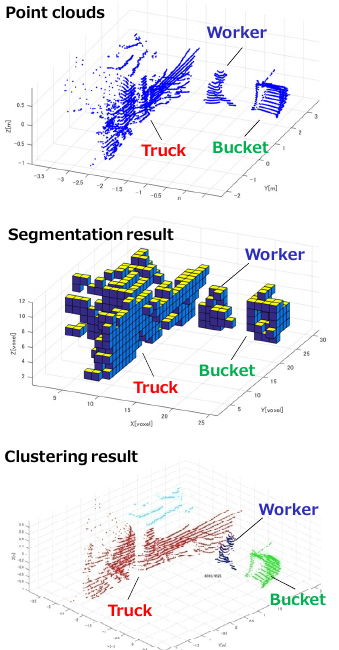
Figure 15. Results after segmenting and clustering of point clouds